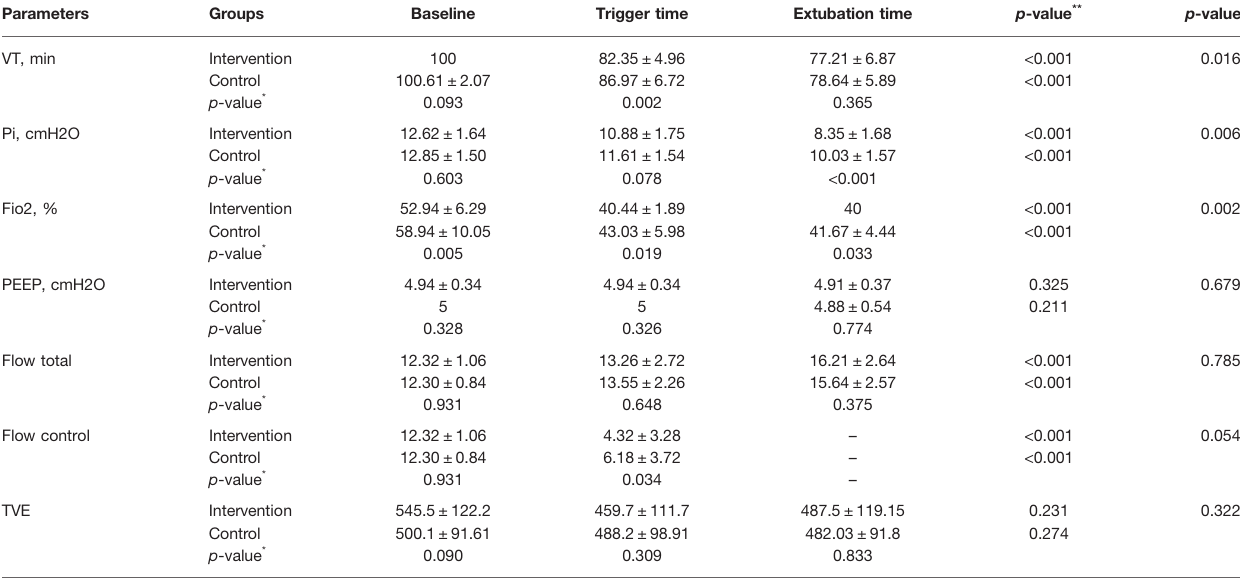
TABLE 2 | Comparison of ventilator and respiratory in three different times between the intervention and control